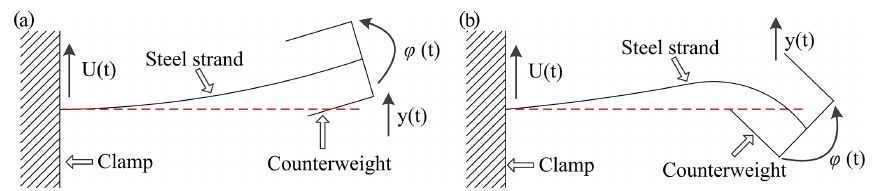
Figure 3. Mode shapes of the beam-counterweight system: (a) the first mode; (b) the second mode.